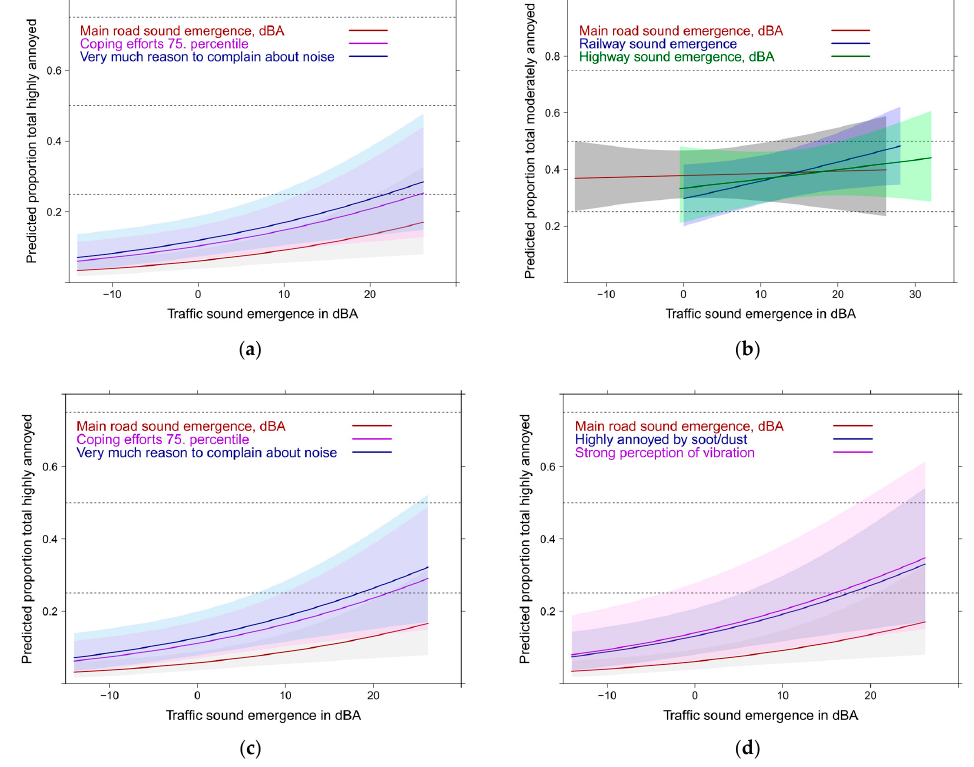
Figure 20. Predicted proportion of total annoyance associated with emergent sound from main roads. ( a ) Proportion highly annoyed associated with the acoustic source indicators; ( b ) Proportion moderately annoyed associated with the acoustic source indicators; ( c ) The relative importance of single behavioral predictors; and ( d ) perceptual predictors for the proportion highly annoyed associated with increasing main road emergence. Models are generally adjusted for age, gender, education, health status and emergence from other sources. Depending on the predictors shown, adjusted for other predictors not shown in the graph (complaints about community soundscape and air pollution, perceived vibration, perceived dust/soot from road, coping, anger at traffic load). Int. J. Environ. Res. Public Health 2017 , 14 , 663